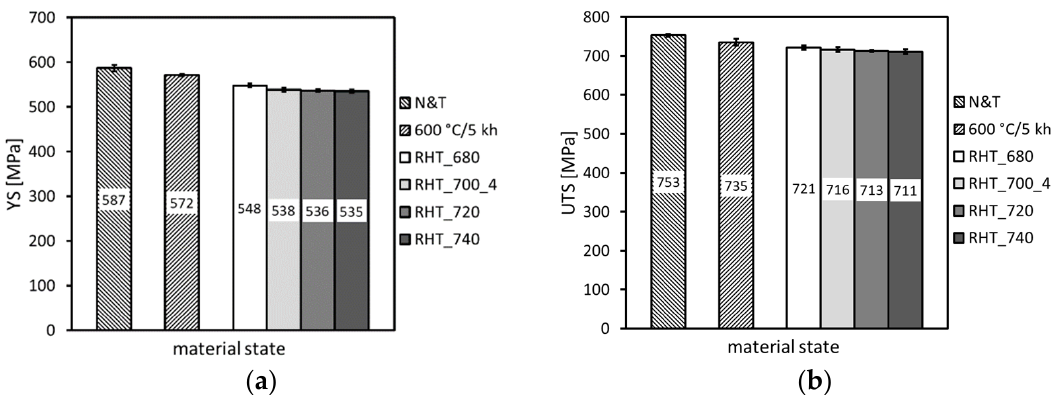
Figure 15. The effect of various annealing temperatures of individual rejuvenation heat treatments with most efficient heating up and cooling down conditions on ( a ) yield stress and ( b ) ultimate tensile strength.